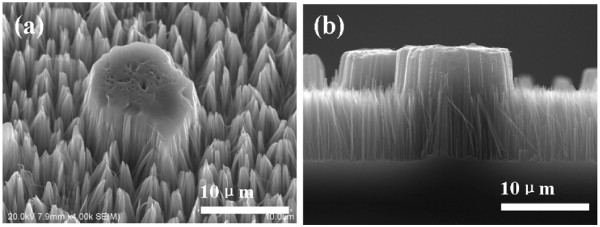
SEM images of silicon MP/NW structure. (a) Plane-view and (b) cross-sectional SEM images of silicon MP/NW structure obtained from the etching of silicon in the solution containing 4.6 M HF, 0.02 M AgNO3, and 0.05 M KMnO4 for 45 min.